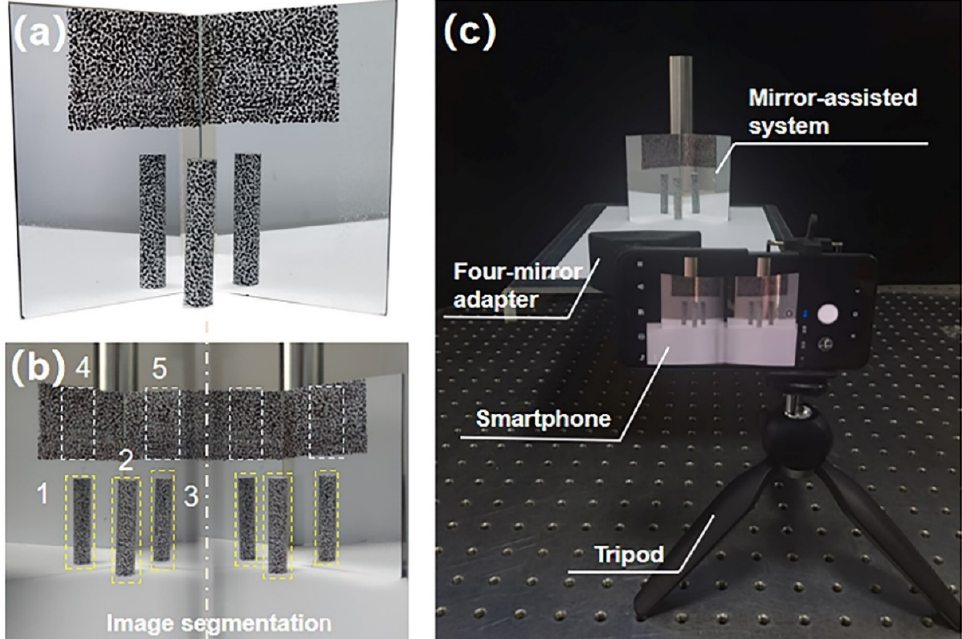
Figure 5. ( a ) Speckle pattern on the aluminum cylinder and two planar mirrors. ( b ) The image captured by the smartphone. The numbers indicated in Figure 5b denote five ROIs selected in DIC calculation. ( c ) The experiment setup of the 360-deg reconstruction experiment.